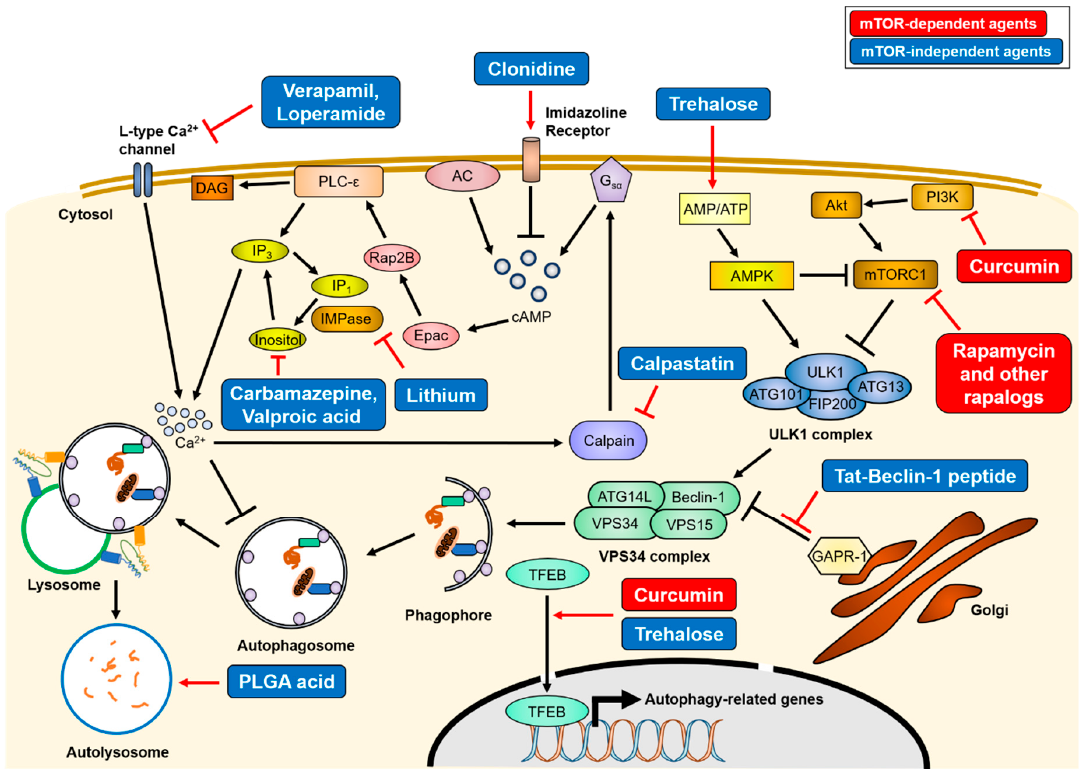
Figure 3. Mechanisms of therapeutics of autophagy-inducing agents. Treatment of various Figure3. Mechanismsoftherapeuticsofautophagy-inducingagents. Treatmentofvariousautophagy-inducing autophagy-inducing agents enhances the clearance of aggregate-prone proteins in an mTOR- agents enhances the clearance of aggregate-prone proteins in an mTOR-dependent or -independent manner. dependent or -independent manner. The mTOR-dependent autophagy inducers (red), rapamycin and The mTOR-dependent autophagy inducers (red), rapamycin and curcumin, directly inhibit mTORC1 activity, curcumin, directly inhibit mTORC1 activity, resulting in activation of the ULK1 complex. Conversely, resulting in activation of the ULK1 complex. Conversely, mTOR-independent agents (blue) upregulate mTOR-independent agents (blue) upregulate autophagy activity through various intracellular autophagy activity through various intracellular signaling cascade or lysosome biogenesis. The simplified signaling cascade or lysosome biogenesis. The simplified actions of the agents are drawn, and detailed actions of the agents are drawn, and detailed mechanisms are described in Section 3. AC = adenylyl cyclase, mechanisms are described in Section 3. AC = adenylyl cyclase, PLC- ε = phospholipase C-epsilon, DAG PLC- ε = phospholipase C-epsilon, DAG = = diacylglycerol.